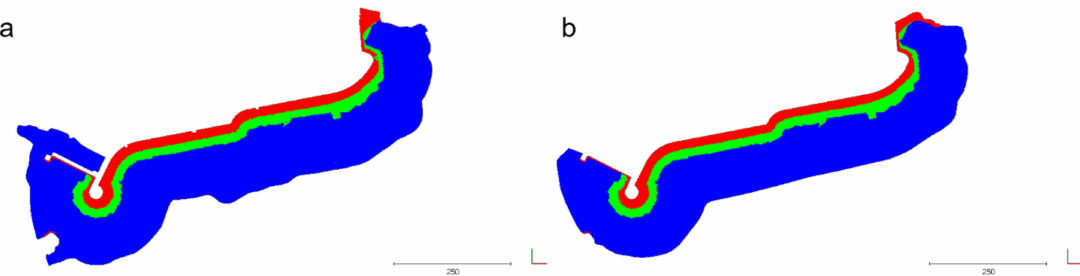
Figure 7. Sea bottom (blue), submerged breakwater (green) and emerged breakwater (red) for DSM 1 ( a ) and DSM 2 ( b